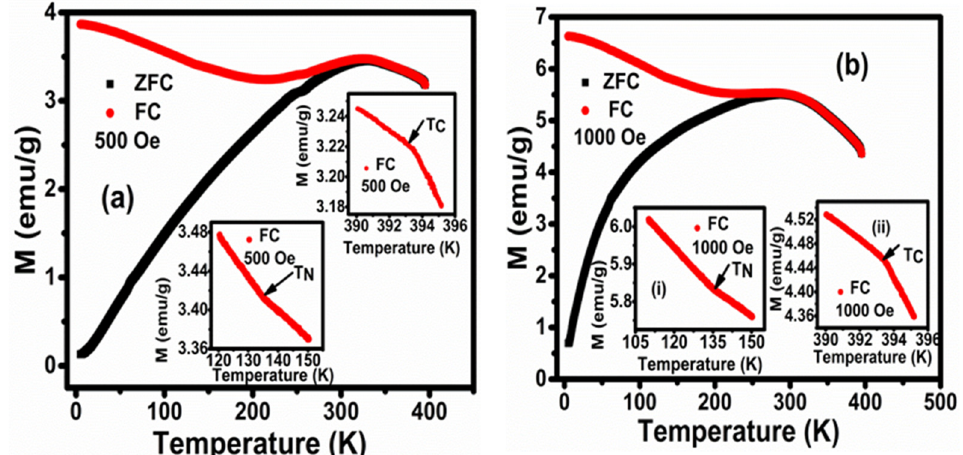
Figure 2. Temperature dependence of magnetization under ZFC and FC conditions of the PC10 composite at ( a ) H = 500 composite at ( a ) H = 500 Oe and ( b ) H = 1000 Oe, the inset shows a magnified view of the ZFC curve Oe and ( b ) H = 1000 Oe, the inset shows a magnified view of the ZFC curve at selected temperature regions. at selected temperature